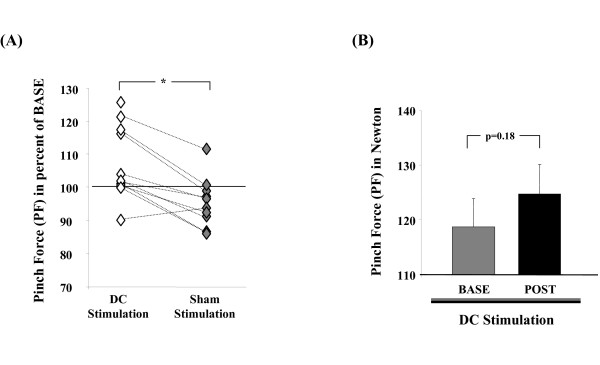
(A) Effects of tDCS on PF (individual subjects). Pinch force after tDCS and Sham relative to baseline (BASE) in all subjects (values > 100 indicate stronger PF, whereas those < 100 indicate weaker PF relative to baseline). Note the significant improvement in PF after tDCS compared to Sham, present in all but one patient (paired t-test, p < 0.05, see also individual subject connecting lines). (B) Effects of tDCS on PF (group data) Group data showed a non-significant trend of increased pinch forces with tDCS (POST) compared to pinch forces during baseline (BASE; paired t-test, p = 0.18).